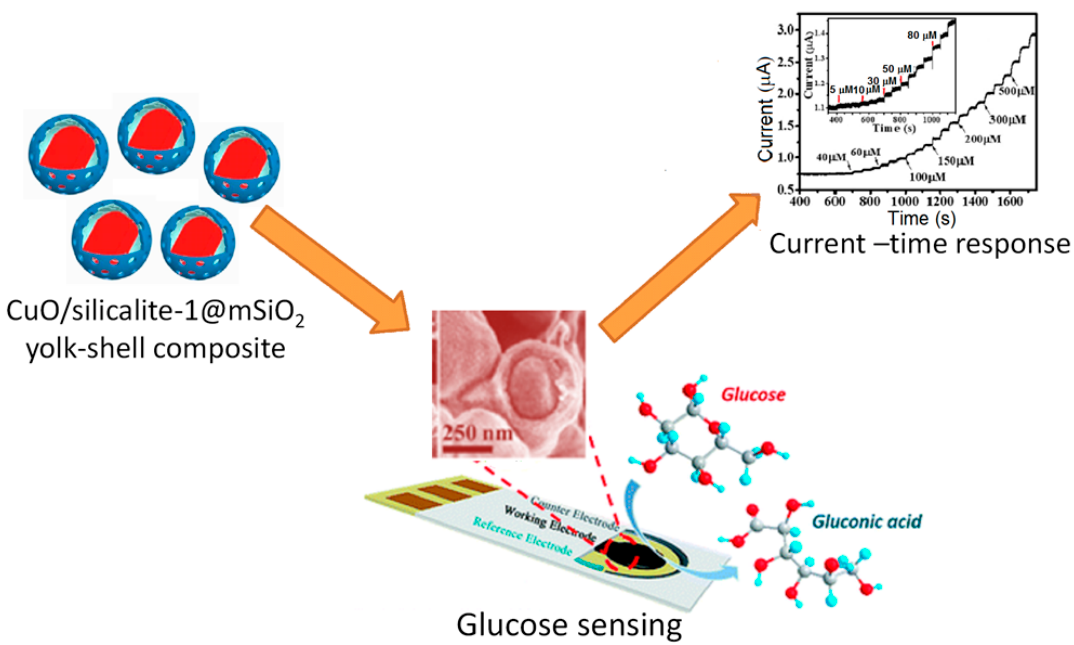
Figure 14. A schematic representation for glucose sensing activity of CuO/silicalite-1@mSiO 2 yolk-shell composite.